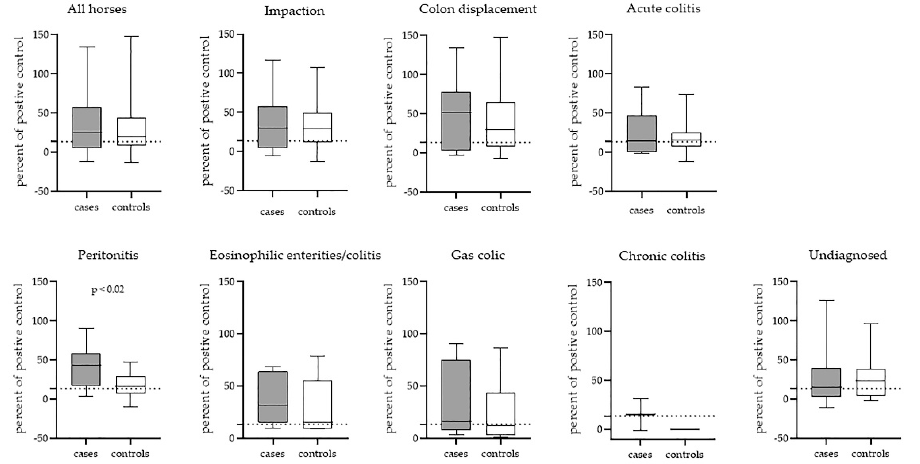
Figure 1. A boxplot illustrating the quantitative enzyme-linked immunosorbent assay (ELISA) values for each colic diagnosis compared with their matched controls. The bold line indicates median, the dotted line indicates the cut-off (13.47) value for positive ELISA.